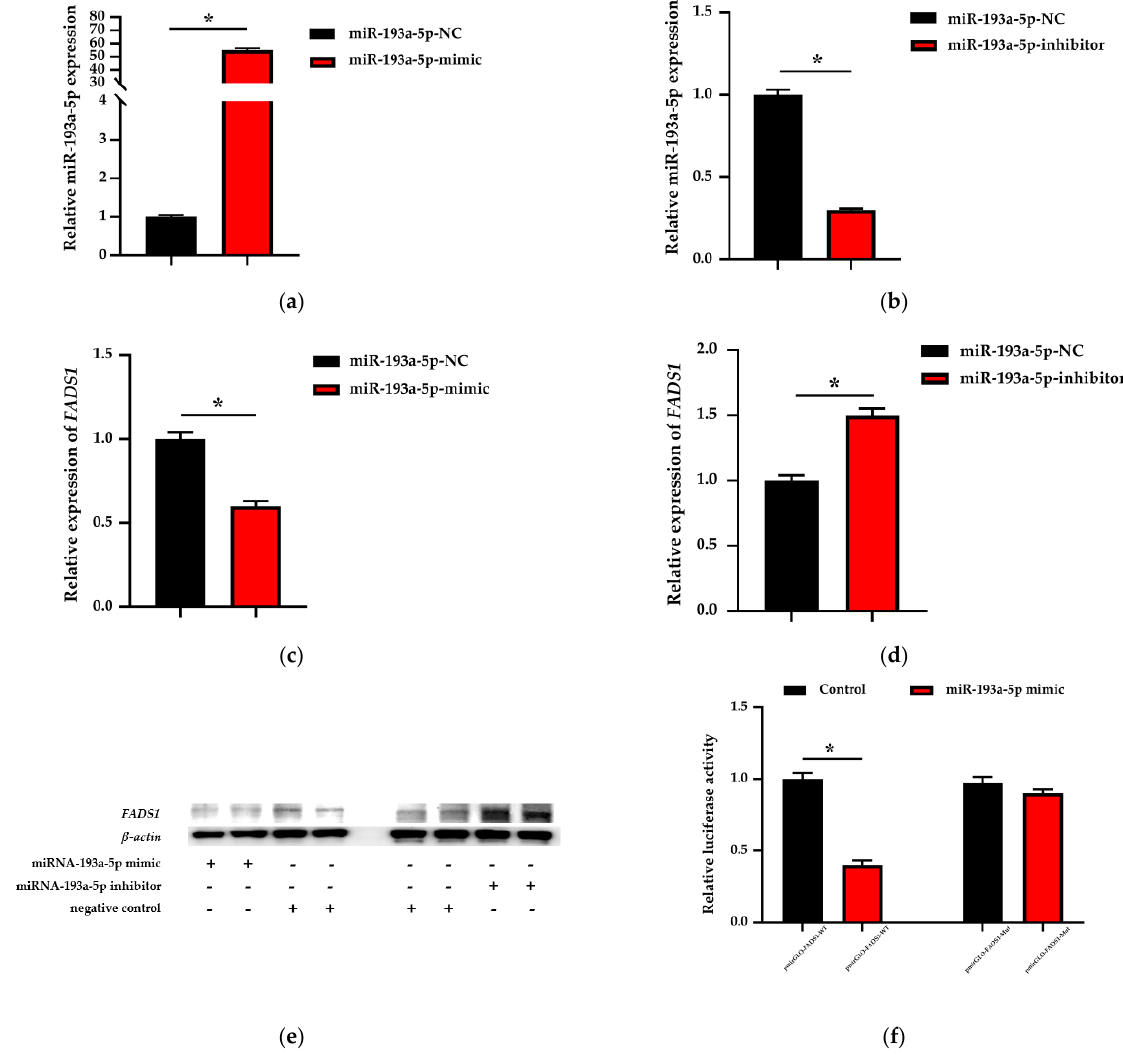
Figure 5. Relative expression of miRNA-193a-5p in BMECs after transfecting the ( a ) mimic and ( b ) inhibitor for 48 h, and the relative mRNA expression of FADS1 after transfecting the ( c ) mimic and ( d ) inhibitor of miRNA-193a-5p for 48 h ( n = 9). NC represents the negative control. ( e ) Relative expression of the FADS1 protein in BMECs after transfecting the mimic and inhibitor of miRNA-193a-5p for 48 h. ( f ) Relative luciferase activity in BMECs that transfected and co-transfected with miR-193a-5p mimic and pmirGLO-FADS1-WT/pmirGLO-FADS1-MUT for 48 h ( n = 9). Data are presented as mean ± standard error (SE). * represents p < 0.05, indicating significant differences between the groups.